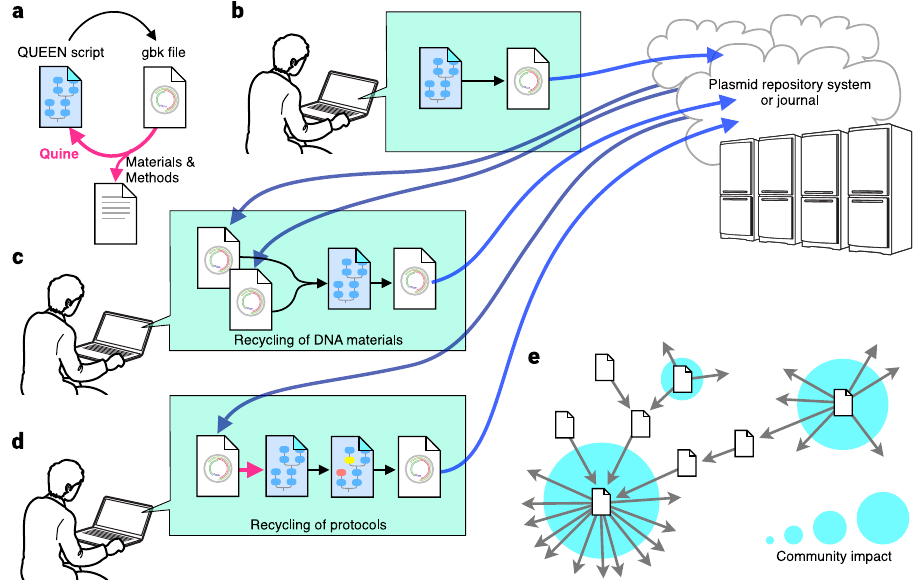
Fig. 1 QUEEN. a QUEEN enables the generation of a quine code from a gbk fi le. b A QUEEN-generated gbk fi le can be deposited to an existing DNA repository as a regular gbk fi le. c When DNA sequences are partially or fully inherited from previous QUEEN-generated gbk fi les to build a new DNA, the producing gbk fi le can contain all the production histories of the ancestral gbk fi les. d When a QUEEN script obtained from a previously established gbk fi le is modi fi ed to design the building process of a new DNA, such a history is also inherited by the produced gbk fi le. e A QUEEN-generated gbk fi le traces its previously utilized DNA materials and protocols, enabling the assessment of community impact of each DNA resource or